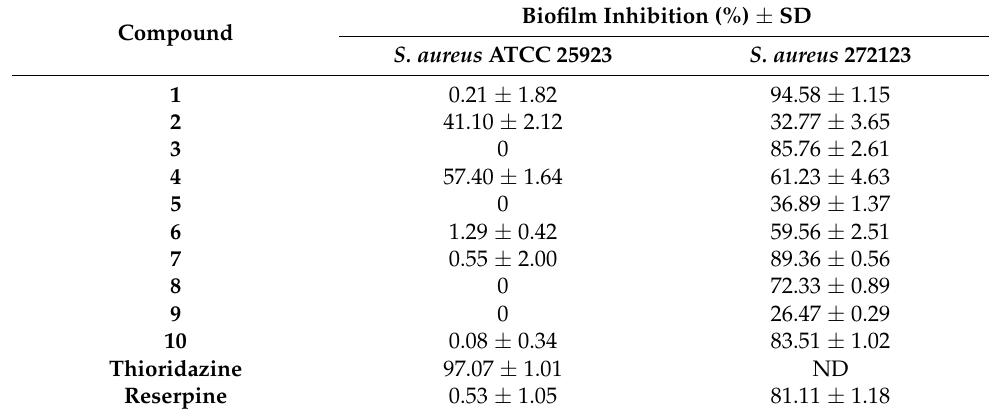
Table 3. Percentage of biofilm inhibition of chalcones 1 – 10